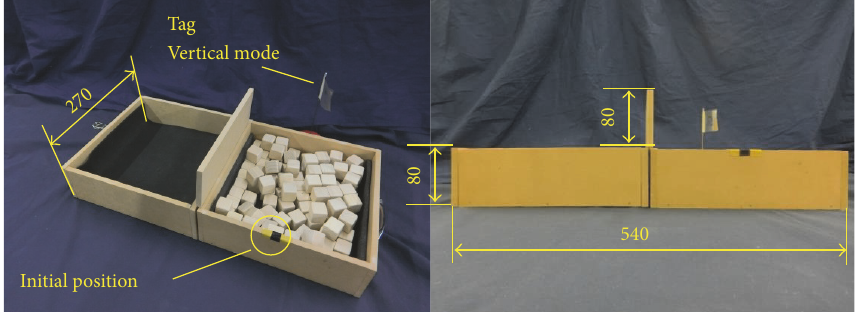
Figure 8: Experimental equipment of Box and Blocks Test.